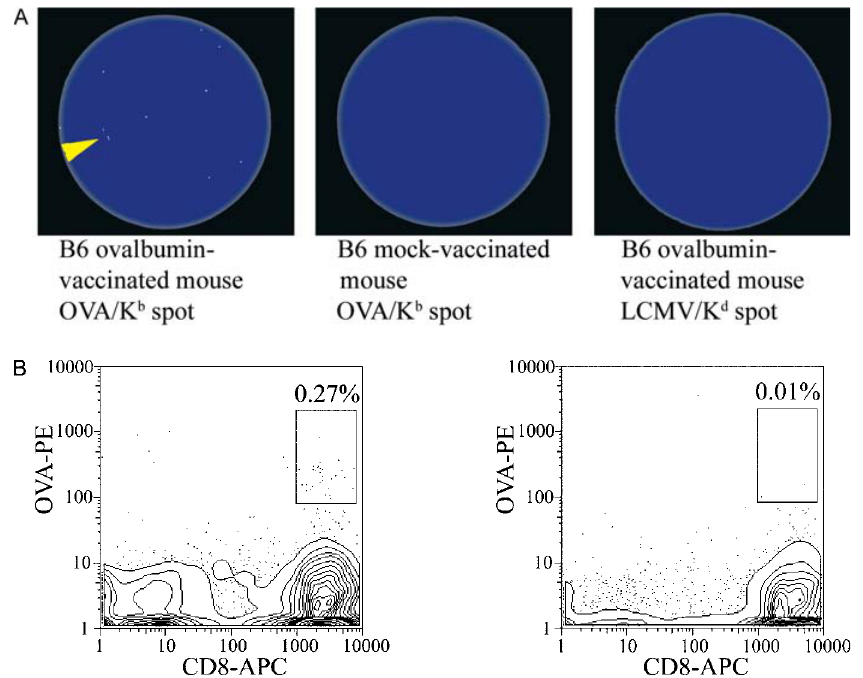
Figure 4. Detection of a Weak Immune Response to Vaccination CTLs from OVA-vaccinated and mock- vaccinated mice were analyzed in paral- lel using an MHC array and flow cytom- etry analysis. Mice received base-of-tail injections of OVA/Freund’s adjuvant emulsions or PBS (mock)/Freund’s adju- vant on day 0 and day 7. Draining lymph nodes were harvested on day 11, and dissociated into a single-cell suspension. (A) CTLs were enriched on an anti-CD8- bead column. Cells (2 3 10 6 and 3.2 3 10 6 ) from the OVA- and mock-vacci- nated mice, respectively, were incubated on identical but separate arrays printed with OVA/K b tetramer, LCMV/K d (con- trol) tetramer, and various antibodies. The three panels show the relevant array results. A rare population of cells from the OVA-vaccinated mouse was captured on the OVA/K b (left), but not on the LCMV/K d (right), tetramer spot. The cells captured on the OVA/K b tetramer spot were CD8 þ (as determined by counter- staining using an anti-CD8–FITC mAb on the array). An arrowhead points to some of the cells that were bound to that spot. The cells from the mock-vaccinated mouse did not bind the OVA tetramer (middle spot) or the LCMV/K d tetramer (data not shown). Spot regions are marked with a blue color by overlaying the tetramer’s PE fluorescent signal onto the DIC image. (B) FACS analysis of the cells from the OVA-vaccinated (left panel) and mock- vaccinated mice (right). Of the total CD8 þ cells from the vaccinated mouse, 0.27% co-stain with OVA/K b , compared with 0.01% in the mock-vaccinated